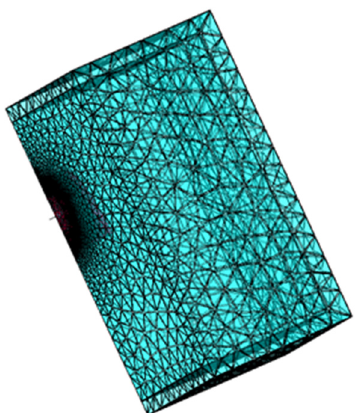
Figure 3. A quarter-pin model in the electromagnetic field of crankshaft N0.